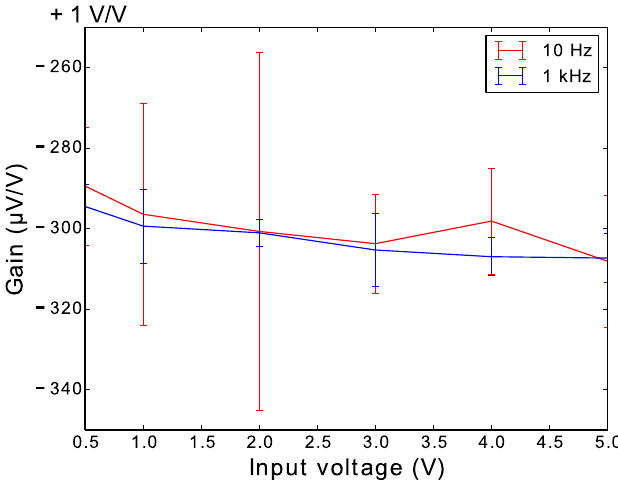
Fig. 5. Resulting absolute ac voltage gain of the buffer. The 10Hz sweep is in red and the 1 kHz sweep is in